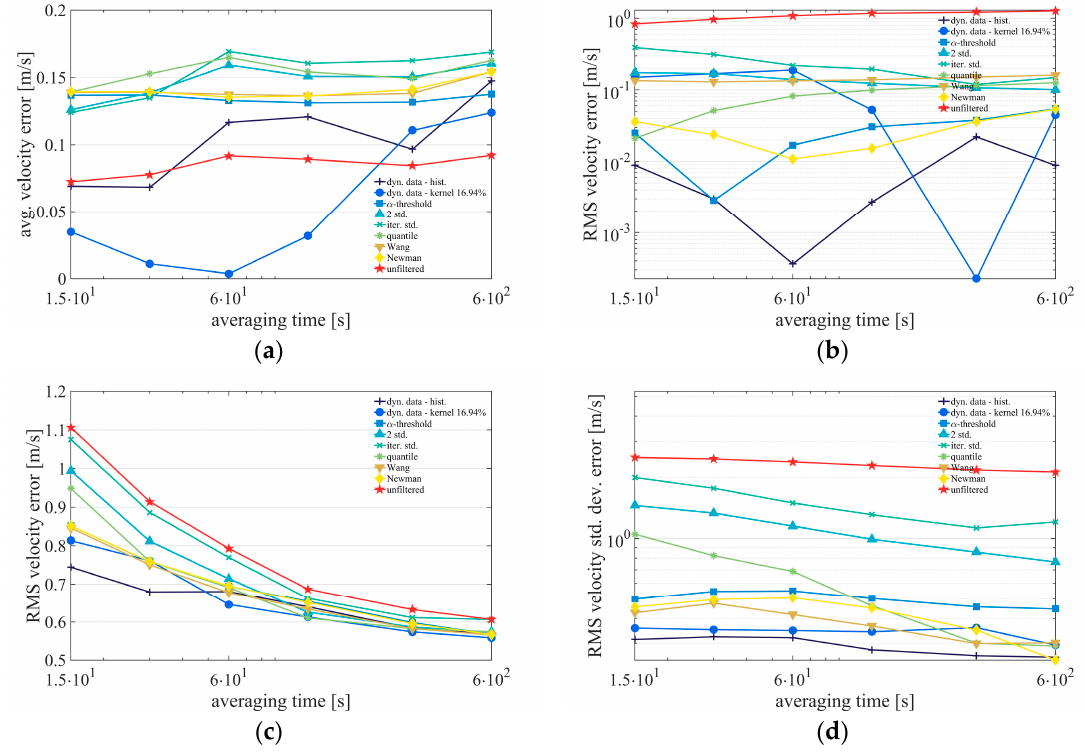
Figure A5. Visualisation of the influence of the averaging time ∆ T for all filters to the resulting errors. ( a ) Average velocity error, ( b ) average velocity standard deviation error, ( c ) RMS velocity error and ( d ) RMS velocity standard deviation error.